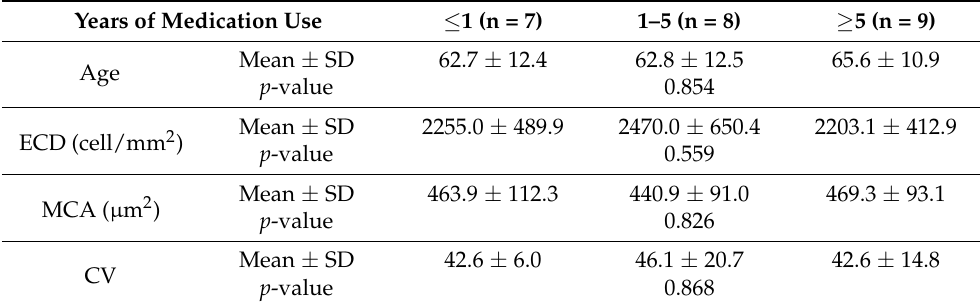
Table 4. ANOVA Models: CEC parameters stratified by years of glaucoma medication